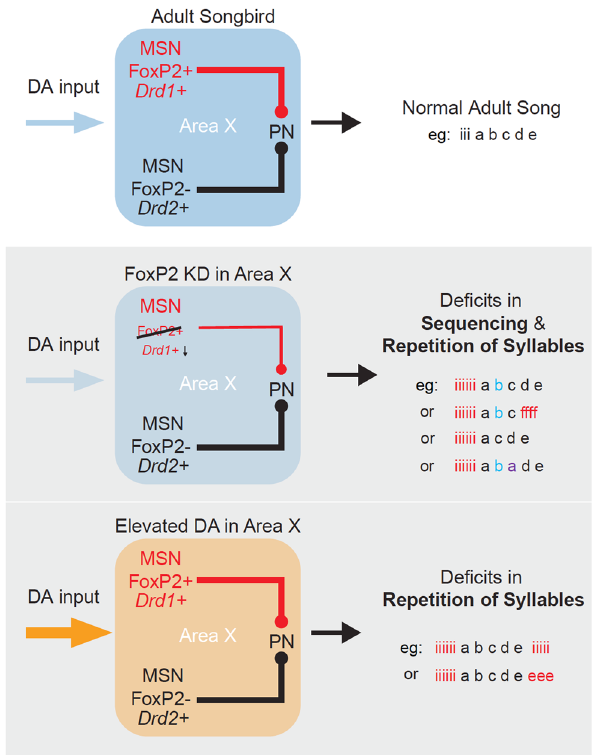
Fig. 9 Hypothetical role of Area X in adult vocalization. Coordinated activity between direct- and indirect-like pathways, as well as appropriate dopaminergic (DA) input into Area X, is needed for the production of normal adult song. Reduced FoxP2 expression in Area X may cause an imbalance in activity between the direct- and indirect-like pathways and result in de fi cits in song sequencing and the repetition of syllables. Similarly, elevated DA input into Area X may introduce the repetition of syllables at the onset or offset of Heterozygous mutations of FOXP2 cause Childhood Apraxia of Speech, also referred to as Developmental Verbal Dyspraxia 31 .